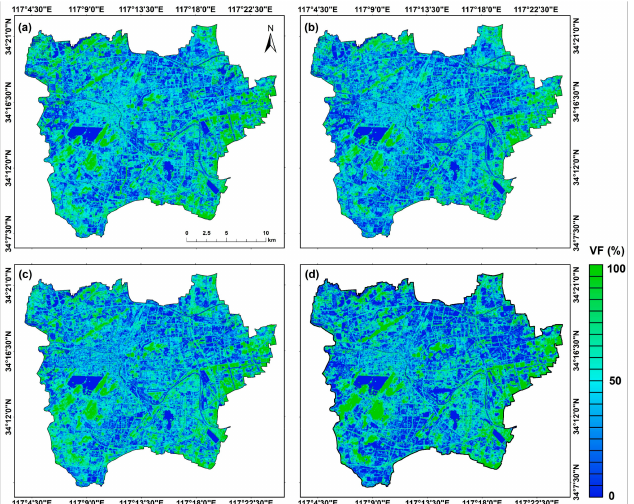
Figure 5. Vegetation fraction inversion maps of ( a ) 1 May 2014, ( b ) 16 May 2017, ( c ) 3 May 2018, and